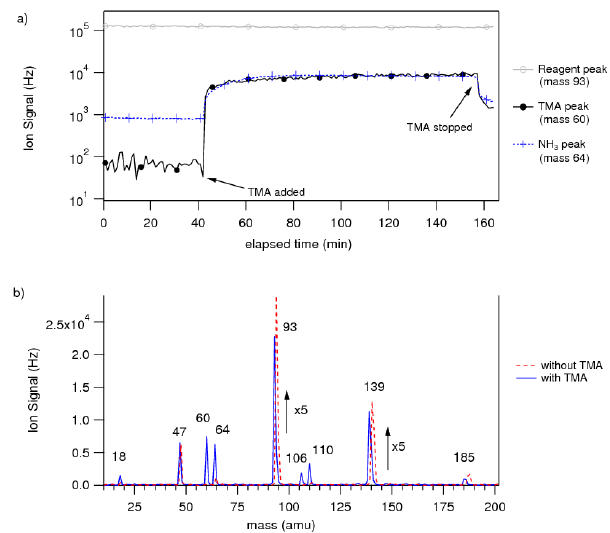
Fig. 1. (a) CIMS-measured TMA (black solid line and filled circles) Figure 1. a) CIMS-measured TMA (black solid line and filled circles) and background NH 3 465 and background NH 3 originated from the TMA permeation tube originated from the TMA permeation tube (blue dotted line and crosses). This figure shows that 466 (blue dotted line and crosses). This figure shows that the production the production of TMA from the permeation tube is steady with time, but NH 3 impurities also 467 of TMA from the permeation tube is steady with time, but NH 3 impurities also exist from TMA. (b) A mass spectrum before and exist from TMA. b) A mass spectrum before and after adding 480 pptv TMA. After addition of 468 after adding 480pptv TMA. After addition of TMA, TMA ion peaks TMA, TMA ion peaks [(CH 3 ) 3 NH + , mass 60 amu; (CH 3 ) 3 N▪(C 2 H 5 OH)H + , mass 106] were 469 [(CH 3 ) 3 NH + , mass 60amu; (CH 3 ) 3 N · (C 2 H 5 OH)H + , mass 106] were clearly observed. Also, NH 3 peaks [(NH 3 , · (C 2 H 5 OH)H + , clearly observed. Also, NH 3 peaks [(NH 3 ▪(C 2 H 5 OH)H + , mass 64; NH 4+ , mass 18] increased, 470 mass 64; NH + , mass 18] increased, indicating that there were some 4 indicating that there were some NH 3 impurities from the TMA source. The spectrum without 471 NH 3 impurities from the TMA source. The spectrum without TMA is right-shifted 2% and mass 93 and 139 are scaled down (5 times) TMA is right-shifted 2% and mass 93 and 139 are scaled down (5 times) for clarity. We have 472 for clarity. We have estimated up to 400pptv of NH 3 impurities in the system (including those from TMA and de-ionized water).